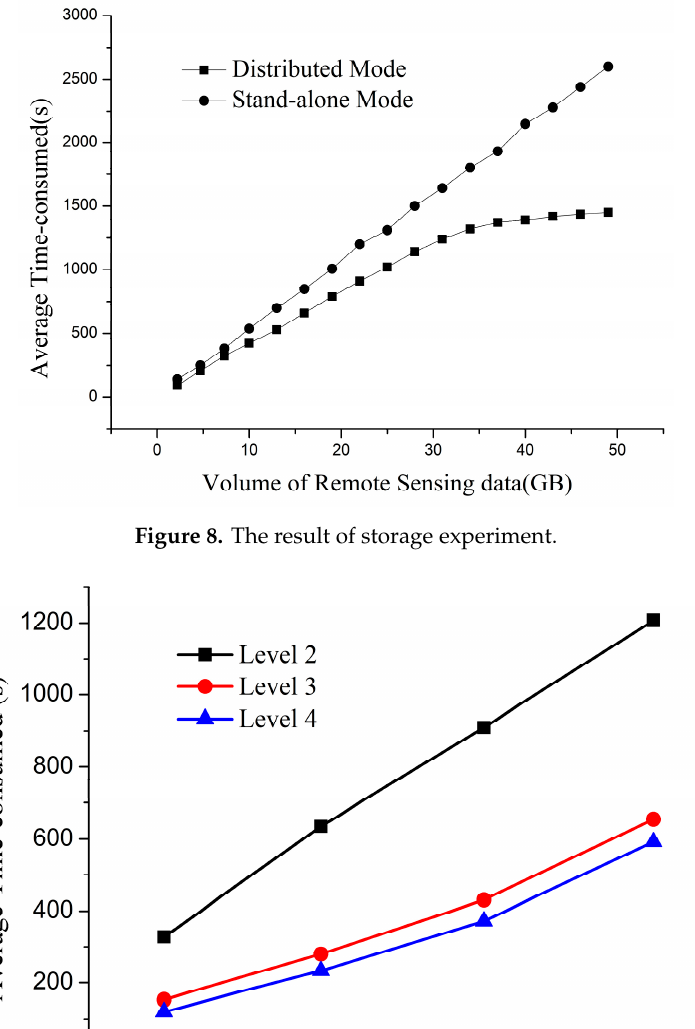
Figure 9. The result of storage experiment with different Level on SSI model.